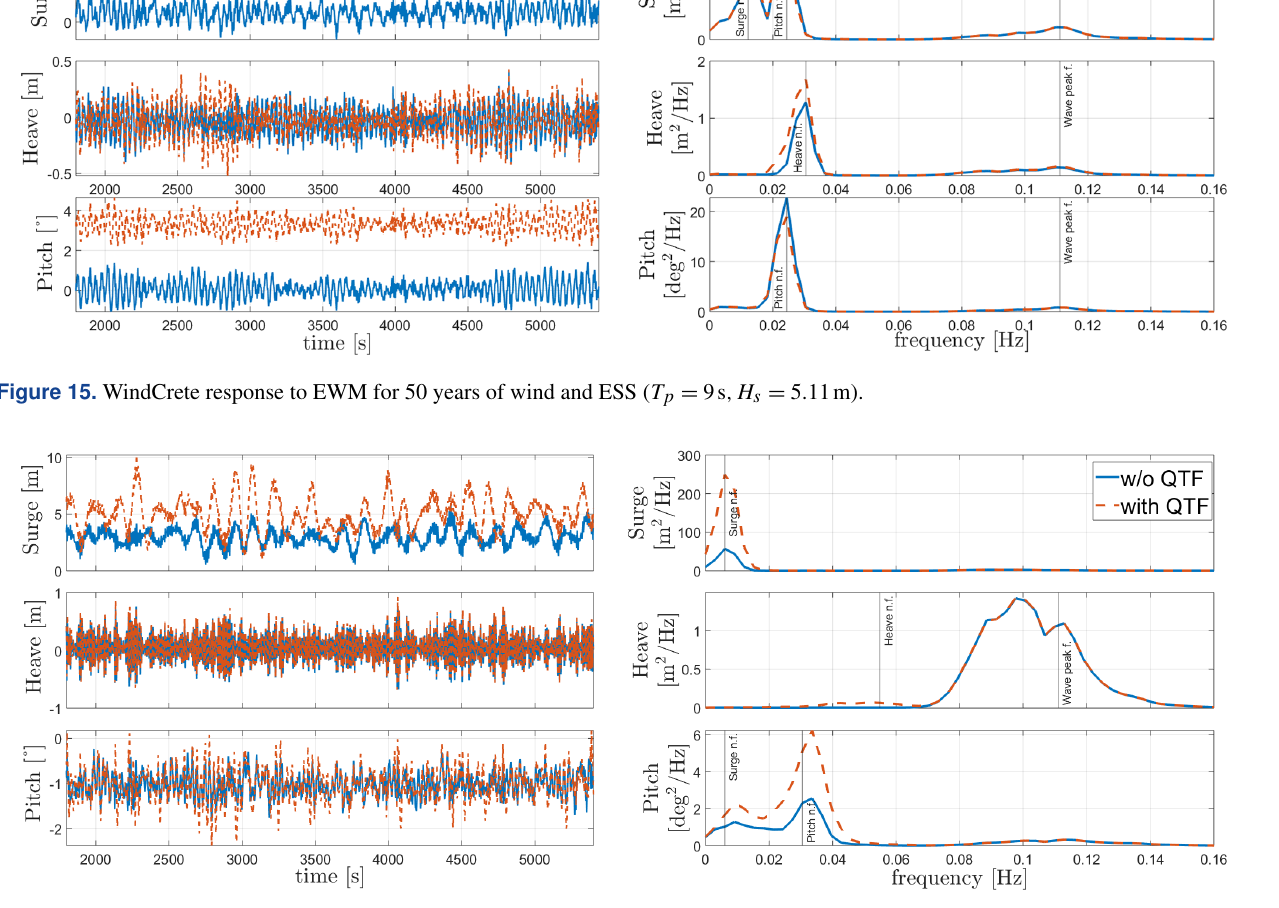
https://doi.org/10.5194/wes-6-867-2021 Wind Energ. Sci., 6, 867–883,